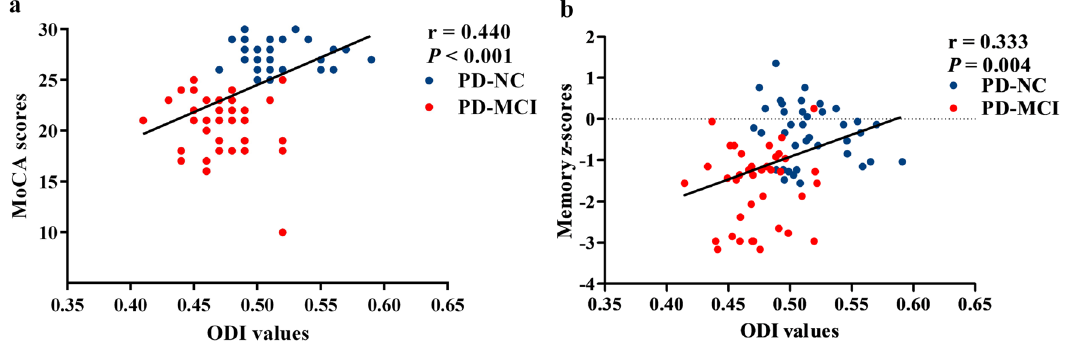
Fig. 3 Correlation analyses in PD patients. The ODI values of the right frontal area were positively correlated with MoCA scores ( a ) and the memory performance ( b ) in all PD patients. ODI orientation dispersion index, MoCA Montreal Cognitive